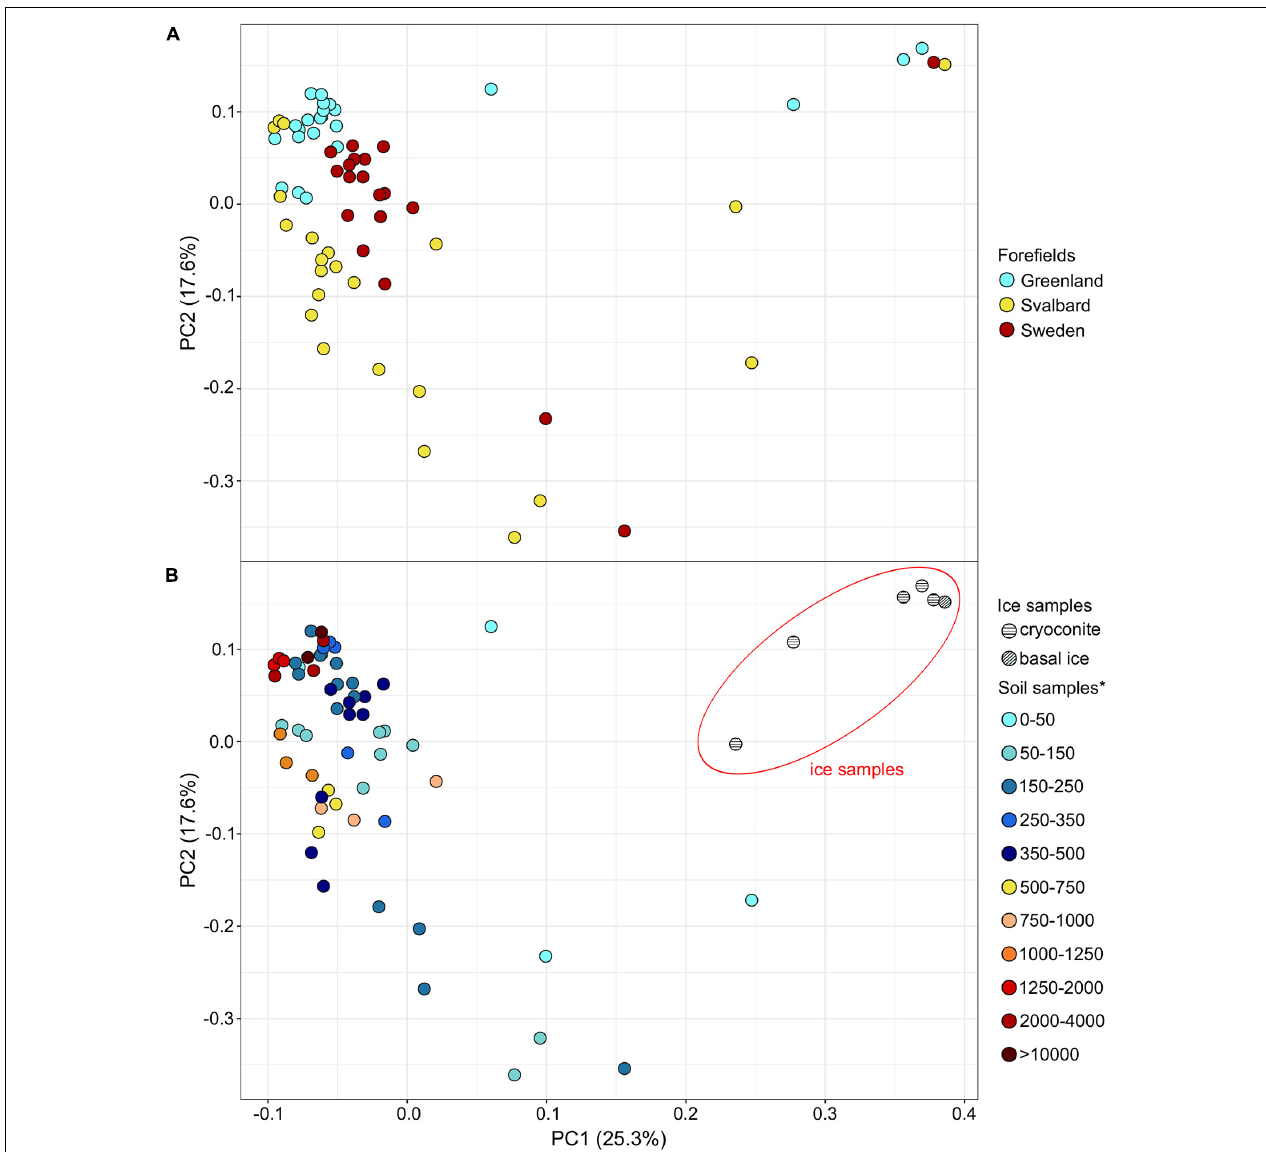
FIGURE 4 | Principal component analysis (PCA) showing the sample distribution based on the genus taxonomic dataset for the forefield color-based samples (A) and ice and soil samples (B) . *Soil samples are categorized in relation to their distance from the ice edge